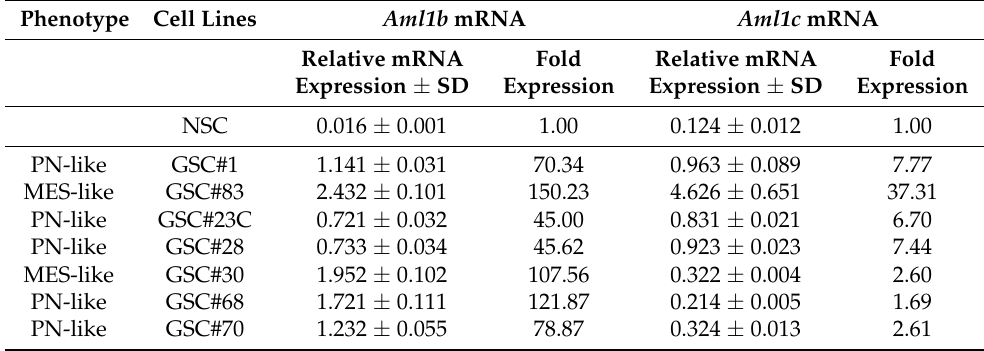
Table 1. Aml1b and Aml1c splice variants mRNA expression in GSCs.